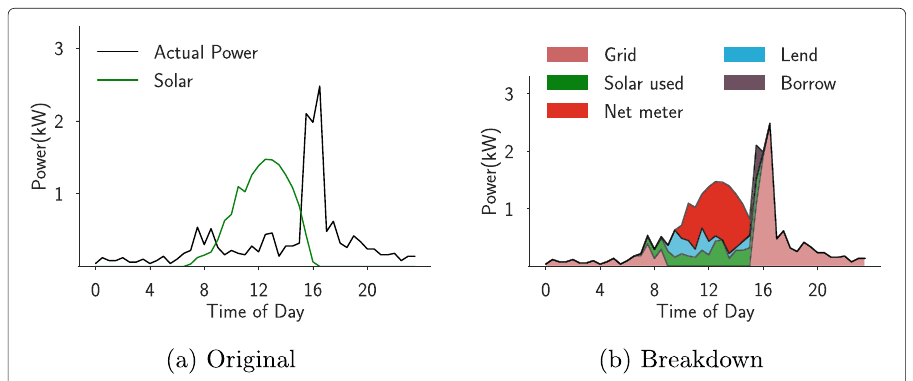
Fig. 8 Energy breakdown of a home’s demand profile with and without energy